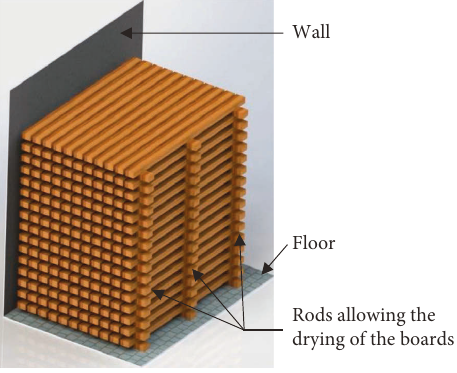
Figure 1: Plank storage and drying plan.